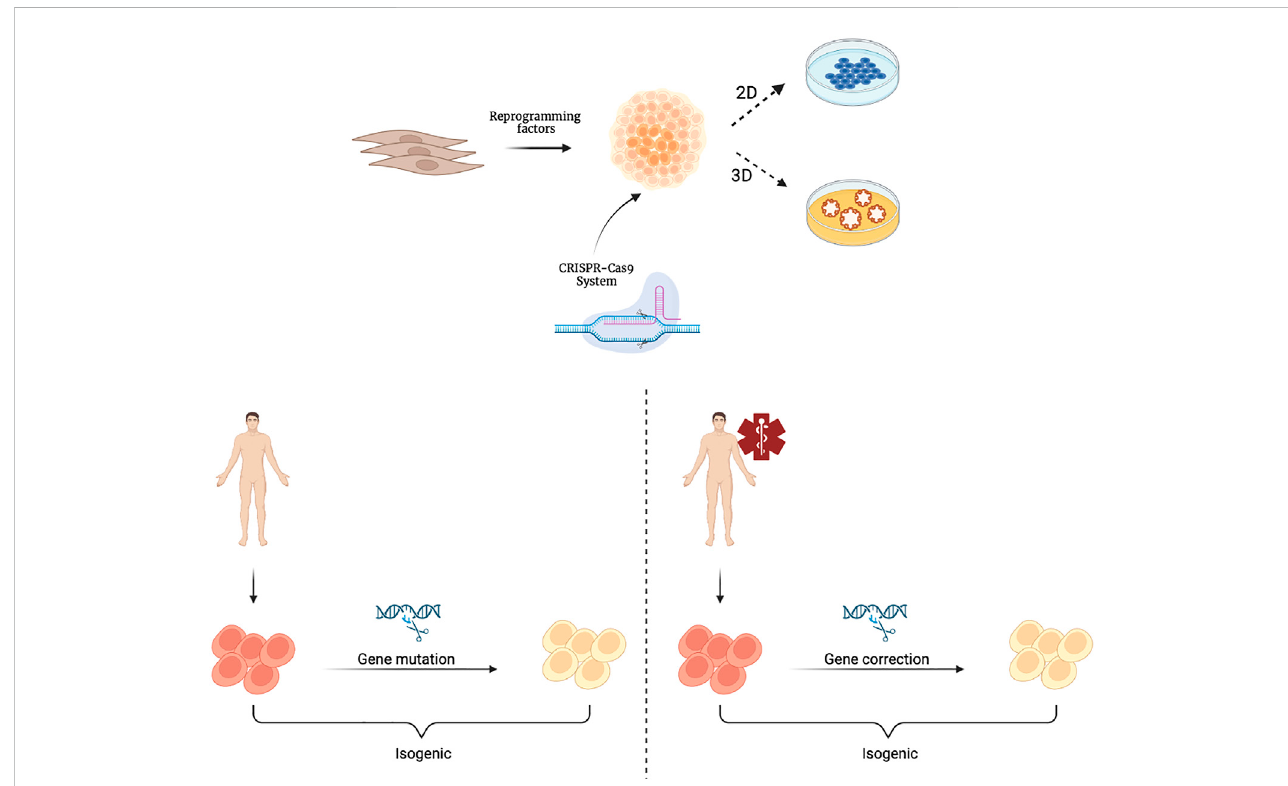
FIGURE 2 Schematic representation of hiPSCs derivation and their gene editing with the CRISPR-Cas9 system. CRISPR-Cas9 technology is applied to cultures of hiPSCsthat can be further differentiatedand cultivated in 2D or 3D organoids. Isogenic hiPSCs or organoids can be obtained from healthy individuals through genetic mutations (left) or from patients through gene corrections (right). Created with